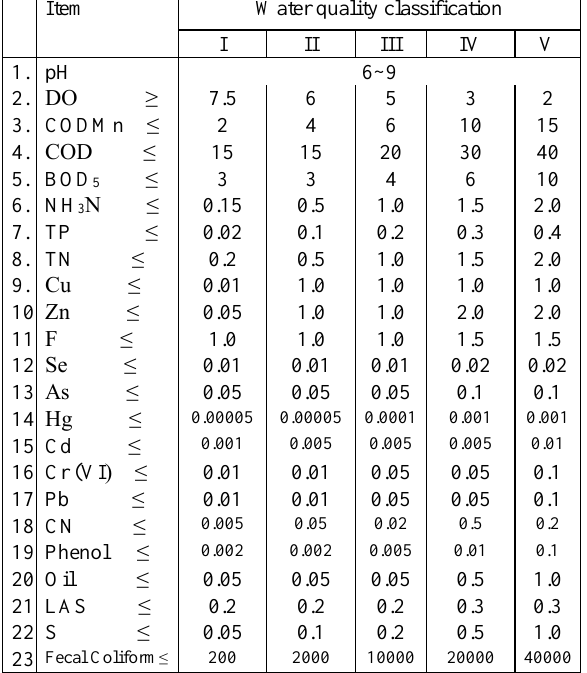
Table 1. Threshold of the main parameters